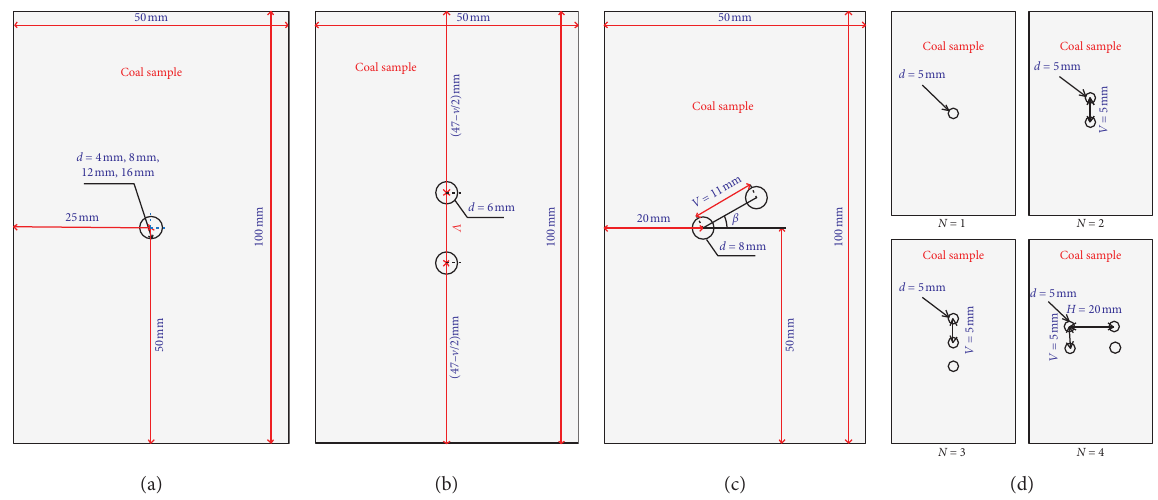
Figure 3: Sketch of hole arrangement in coal sample: (a) different hole diameter; (b) different hole spacing; (c) different hole relative angle; (d) different hole number.